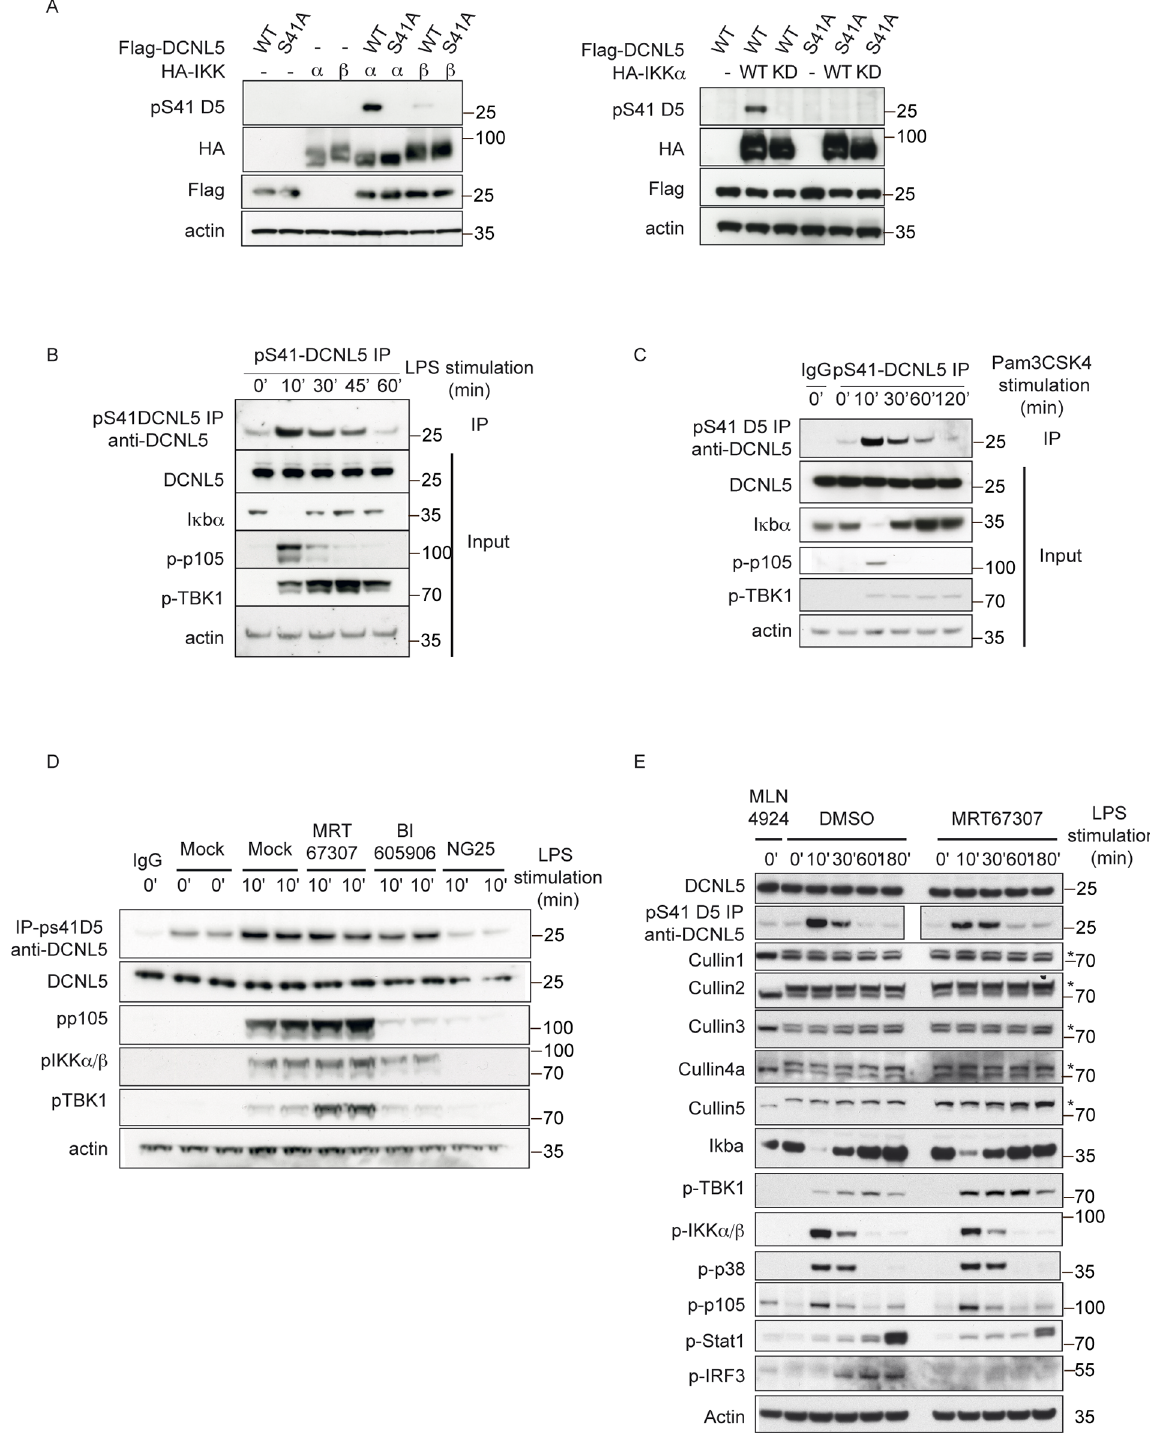
Fig 2. DCNL5 is phosphorylated on Serine 41 by IKK α in RAW264.7 macrophages upon TLR stimulation. (A) HEK293 cell lines were transfected with Flag tagged DCNL5 WT or S41A and HA-tagged IKK α / β WT (left panel) or kinase dead mutant (right panel). The cell lysates (30 μg) were resolved on SDS-PAGE and analyzed by immunoblotting with indicated antibodies. (B) RAW264.7 macrophages were treated with 100 ng/ml LPS over the indicated time period and subjected to immunoblot analyses. To visualize the phosphorylated form of DCNL5, cell extracts were subjected to immunoprecipitation using the phospho-specific antibody and analyzed by immunoblot with a total DCNL5 antibody.